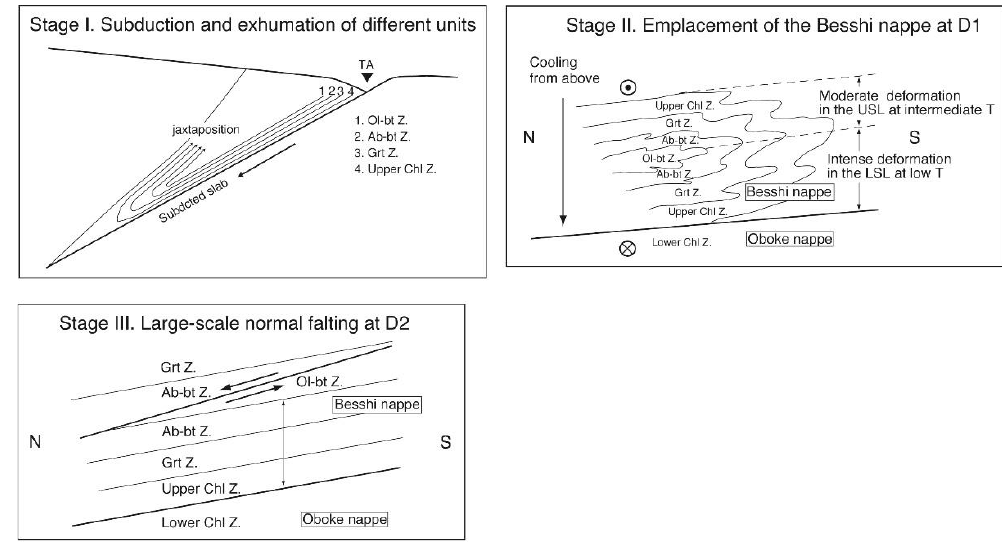
Figure 9. Schematic diagram to show the proposed structural development during exhumation of the Sambagawa metamorphic rocks. Stage I : Subduction and exhumation of different metamorphic zones 1 through 4. These zones successively subducted and were exhumed in this order acquiring the unique phengite K-Ar ages. TA, trench axis. Stage II : Emplacement of the Besshi nappe over the Oboke nappe at the later stage of the D1 phase. During the nappe emplacement, schematically illustrated D1 folds were formed by an E-W flow [35]. The main schistosity (S1) is parallel to the axial plane of D1 fold (not illustrated). A pair of symbols consisting of a dot and cross in a circle indicates the sense of the E-W flow (top to the west sense). The upper chlorite zone of the upper structural level is probably eroded at present. Stage III : Large-scale normal faulting at the D2 phase, which destructed the structure of the Besshi nappe. Large arrows indicate the sense of fault movement (normal sense). See text for further explanations.